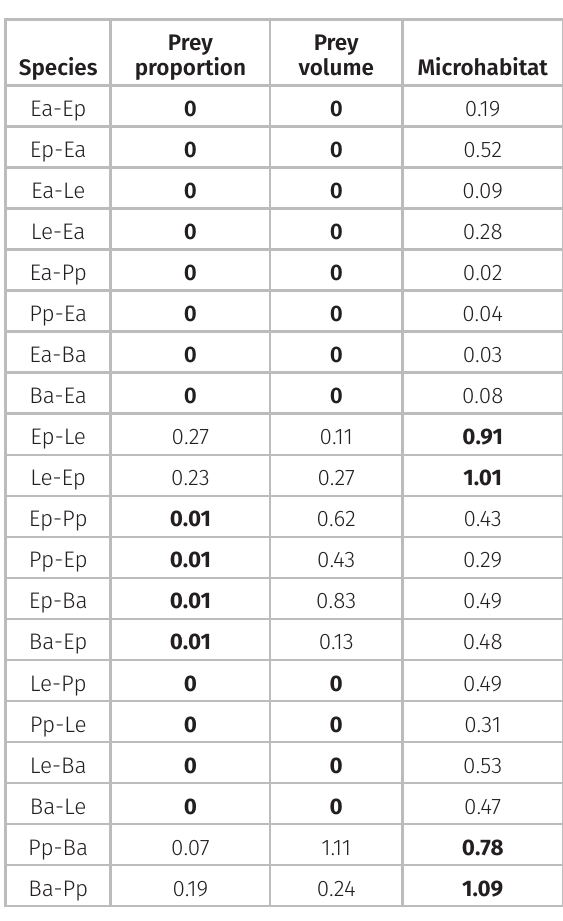
Table IV. Overlap values of MacArthur & Levins (1967) for prey proportion, prey volume and microhabitat use. Significant species pairs are shown in bold. See text for details of calculations. Other references as in Table